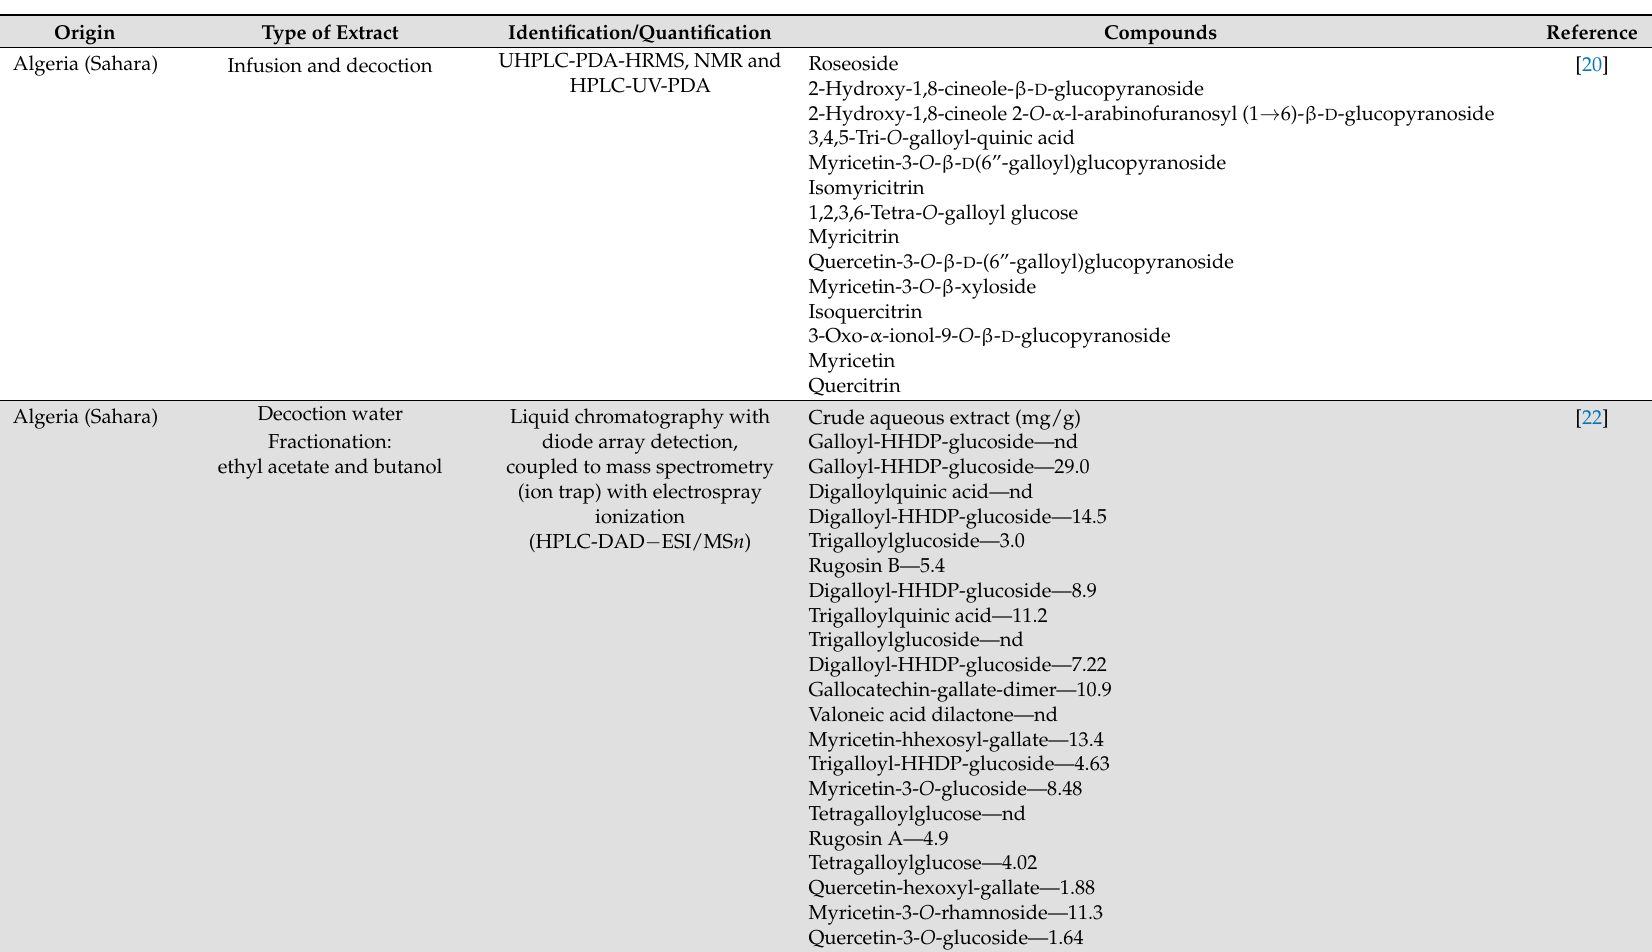
Table 4. Phenols and flavonoids in Saharan myrtle